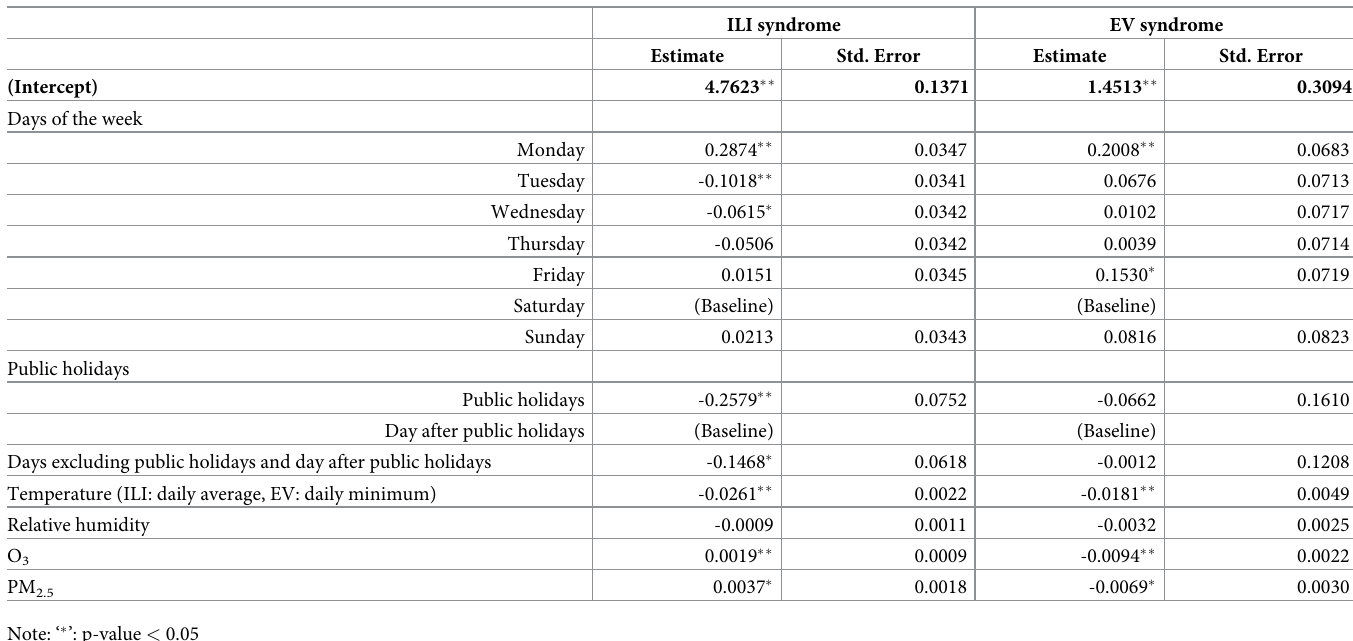
Table 3. Estimated coefficients from negative binomial